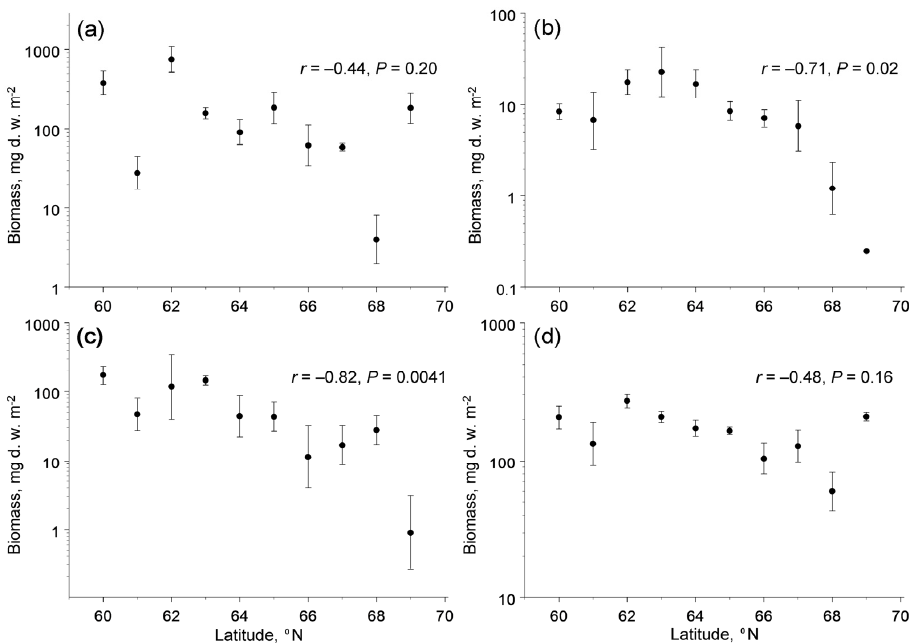
Figure 3. Latitudinal patterns in biomass (mg d.w. m − 2 ) of four trophic groups of soil macrofauna (means and 95% confidence intervals, each based on four sampling dates): ( a ) detritivores; ( b ) fungivores; ( c ) herbivores; ( d ) predators. Note that the scales of the vertical axes differ among the panels.